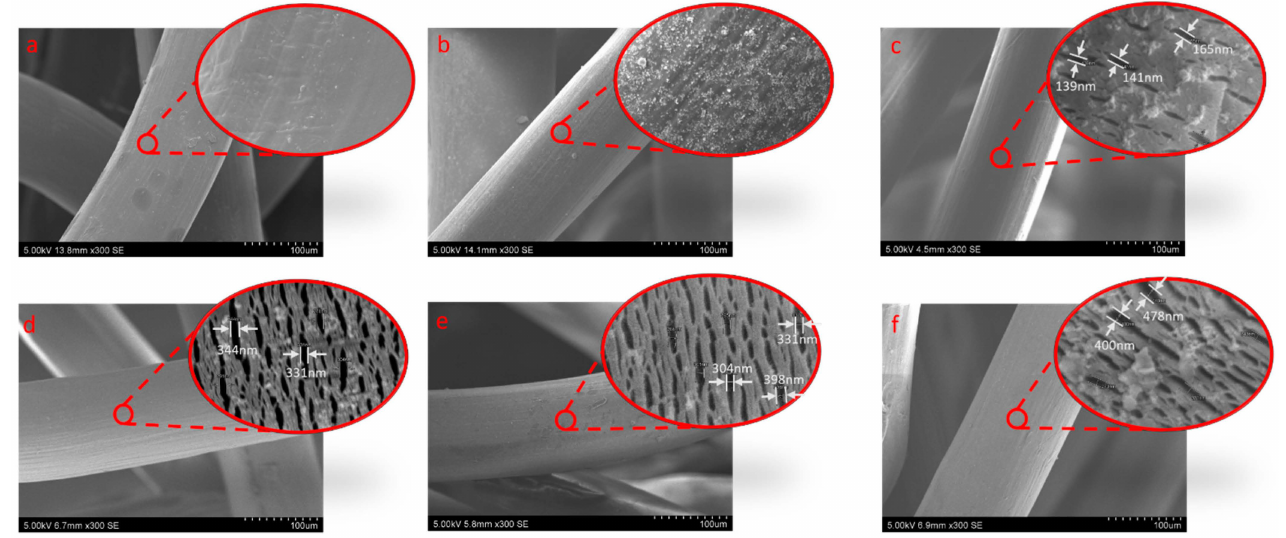
Figure 7. SEM micrograph of composite fabrics at ( a ) Month 1, ( b ) Month 2, ( c ) Month 3, ( d ) Month 4, ( e ) Month 5, and ( f ) Month 6 of